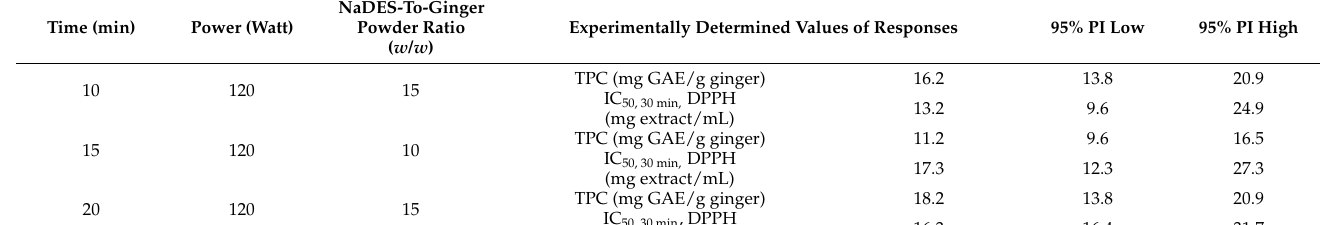
Figure 4. RSM plots for TPC response showing the correlation between TPC and the factors: ( a ) time and NaDES-to-dry ginger ratio, ( b ) time and ultrasound power.